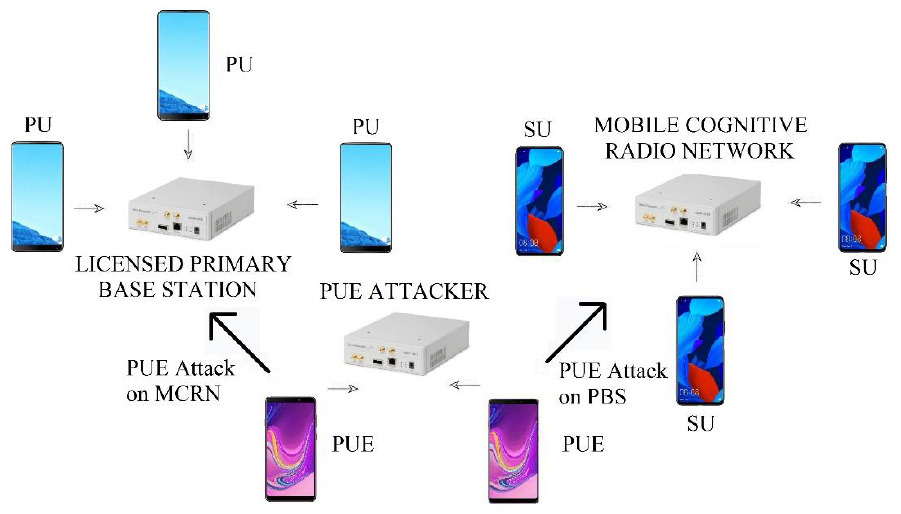
Figure 7. Testbed for SDR experiments.